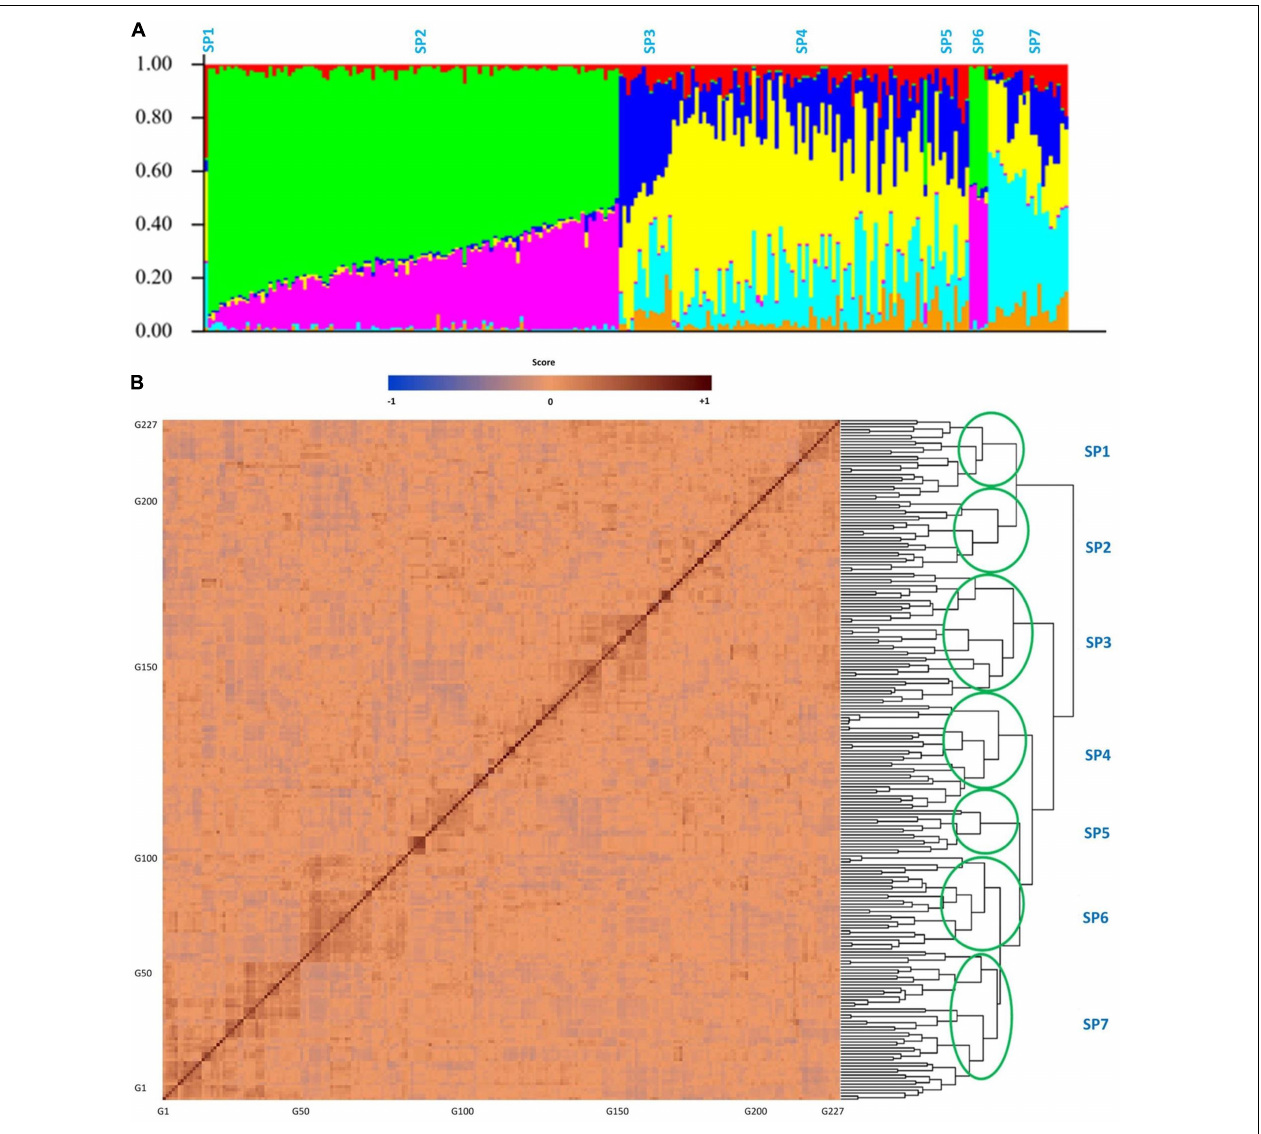
FIGURE 7 | Structure (A) and kinship (B) plots for the 227 soybean genotypes. The x -axis represents the number of genotypes used in this GWAS panel, and the y axis represents the membership of each subgroup. SP1–SP7 stands for subpopulations 1 to